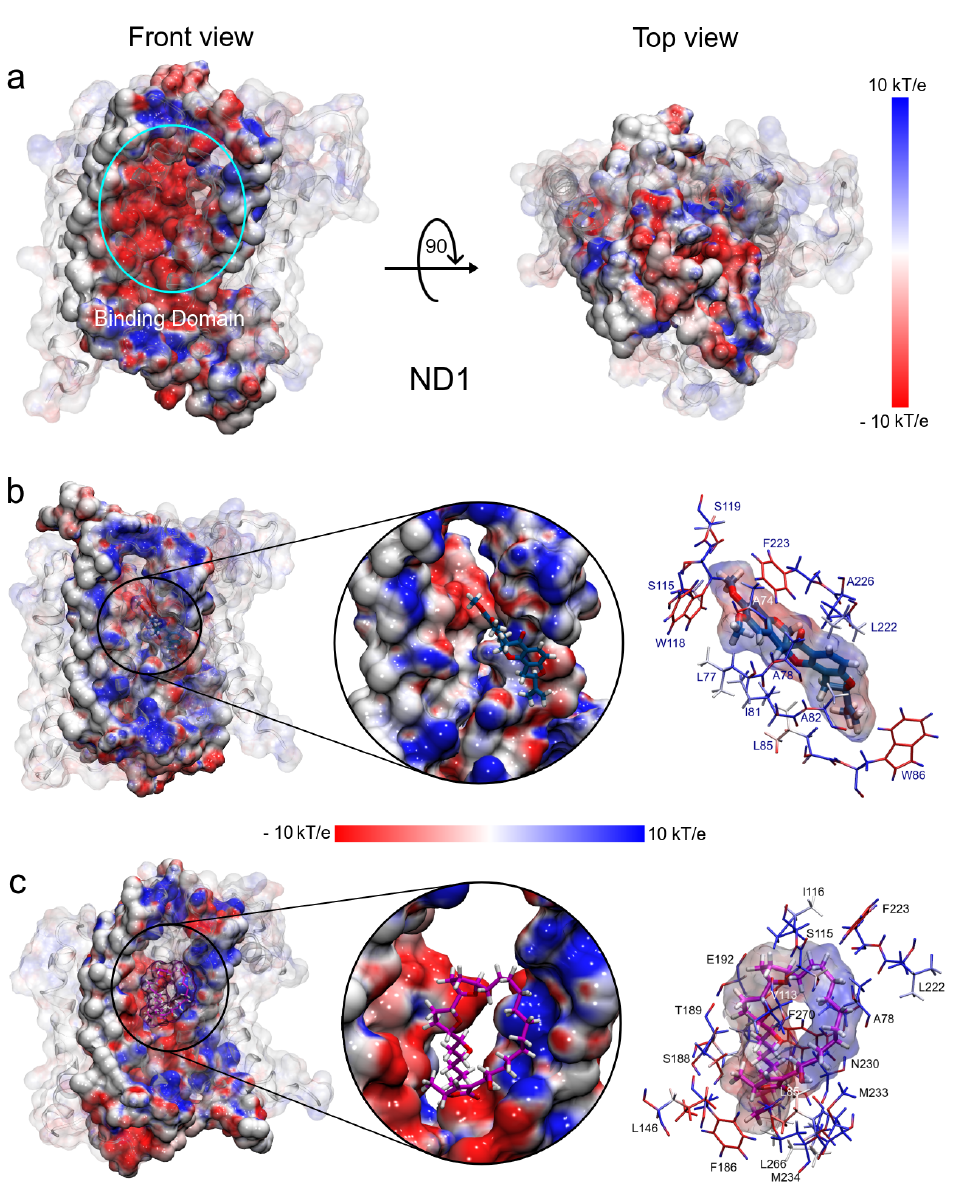
Figure 8. Electrostatic potential surfaces of molecular systems obtained with APBS. ( a ) ND1 protein structure. ( b ) ND1—rotenone complex. ( c ) ND1—annocatacin B complex. The red color indicates negatively charged regions and blue, positively charged. White color denotes hydrophobic